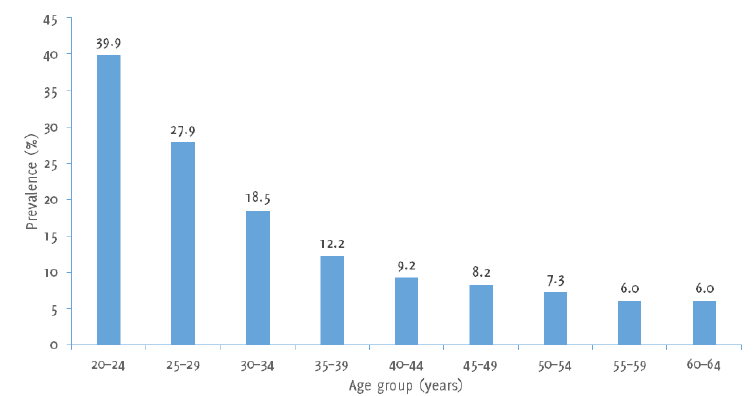
Figure 1. Prevalence of High-Risk HPV Infection among Females Undergoing Cervical